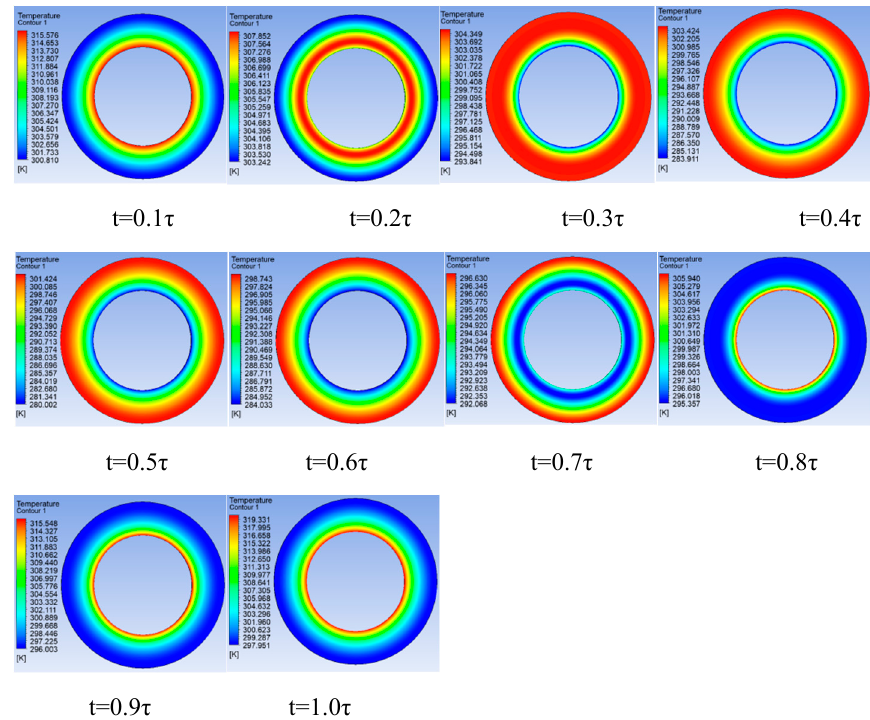
Figure 14. Temperature distribution cloud diagram of circular tube at different times.